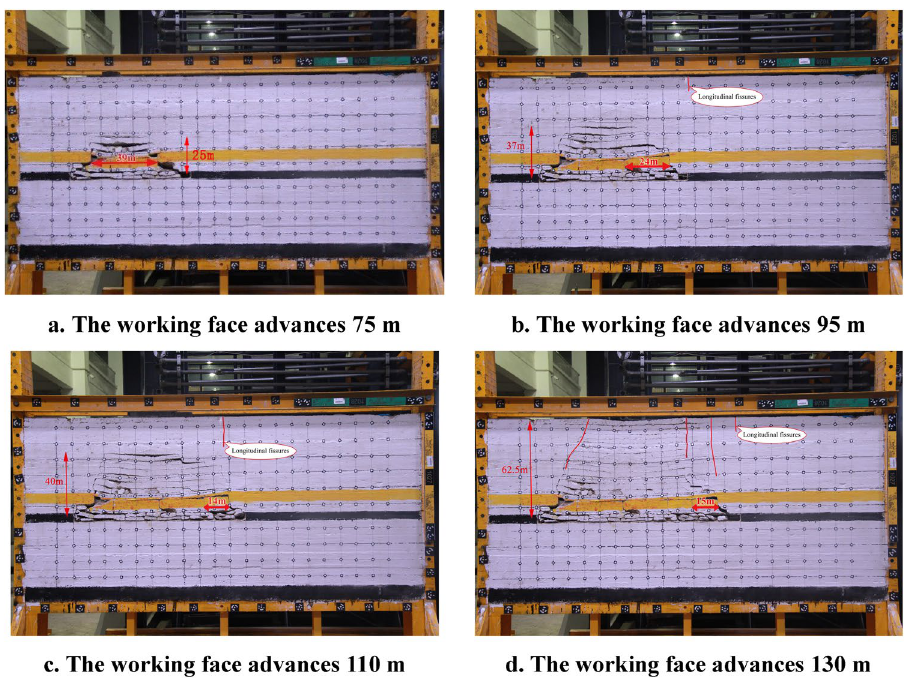
Figure 4. Overburden rock instability characteristics and fissures distribution characteristics of the key bearing layer located within the caving